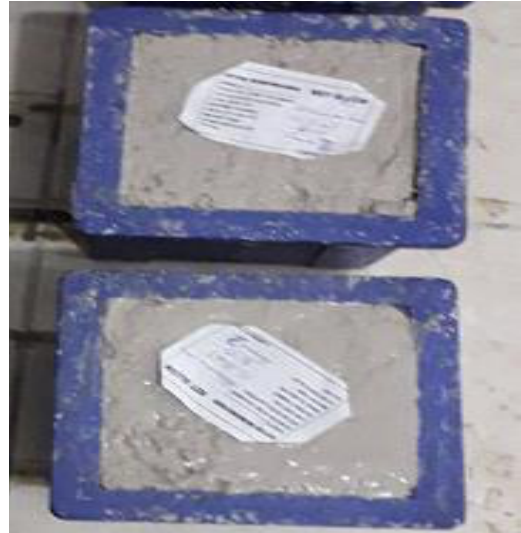
Figure 6. Pumice binder mortar for optimum binder fixation.